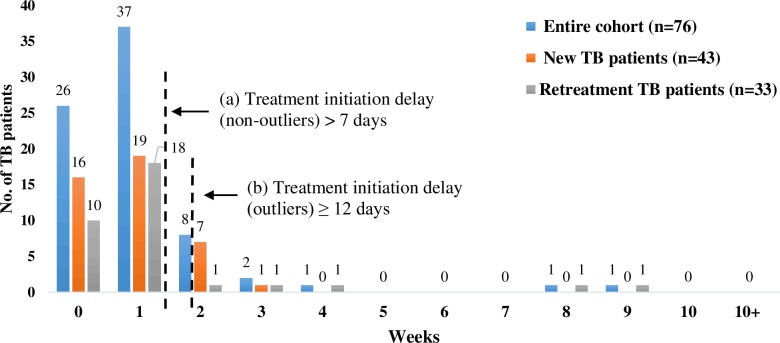
Initiation of Treatment: Duration and Delays.The figure represents the time taken from diagnosis of PTB to the initiation of anti-TB treatment. The serrated lines depict the durations that reflect (a) delay and (b) outliers.